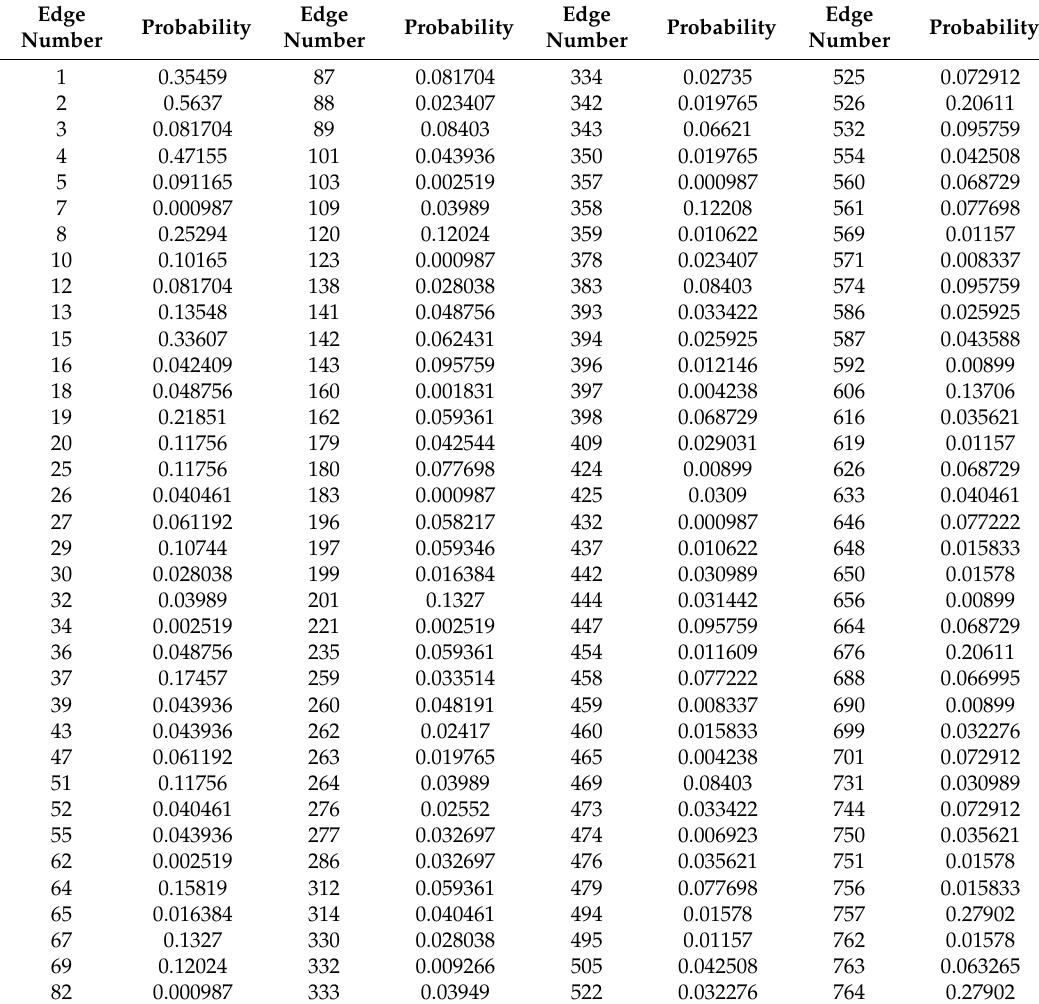
Table A1. Defender’s strategy generated by the CCEPP